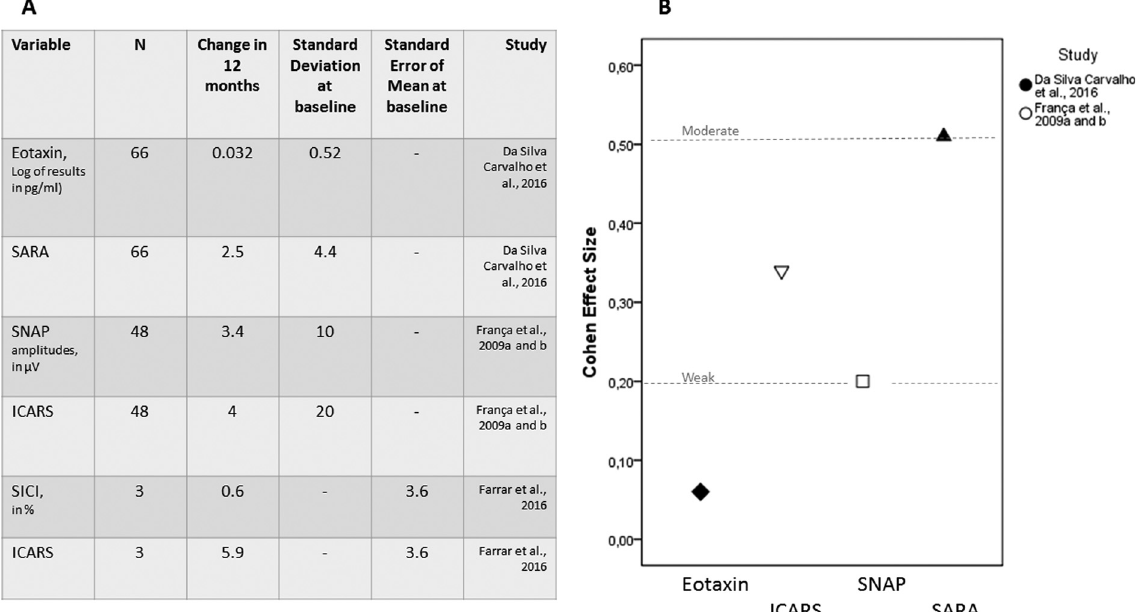
Figure 1 - Candidate biomarkers that have been followed longitudinally in SCA3/MJD subjects. (A) Summary of the longitudinal data obtained for eotaxin and Scale for Assessment and Rating of Ataxia (SARA); sensory nerve action potential (SNAP) amplitudes of sural nerves and International Co- operative Ataxia Rating Scale (ICARS); and short-interval intracortical inhibition (SICI) of motor evoked potentials and ICARS. (B) Cohen effect sizes, when available or when estimation was